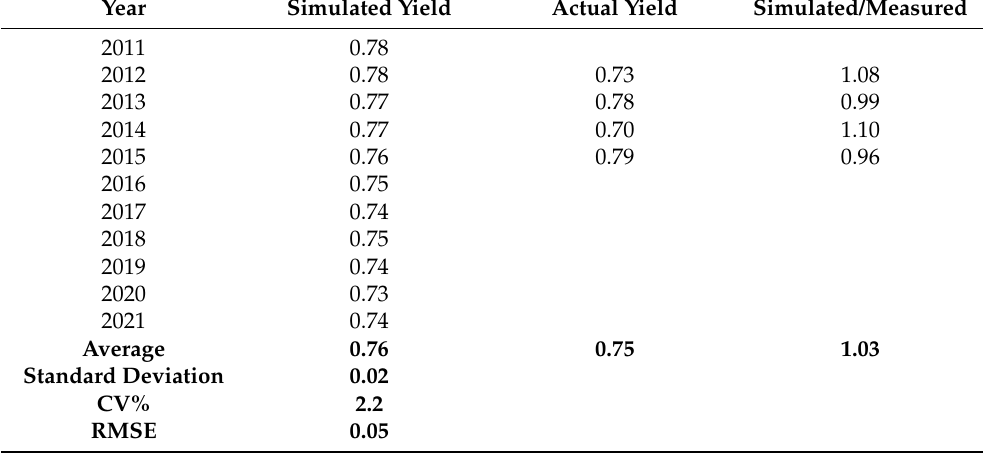
Figure 1. Coffee yields (in Hawai’i) measured and simulated with the ALMANAC model.